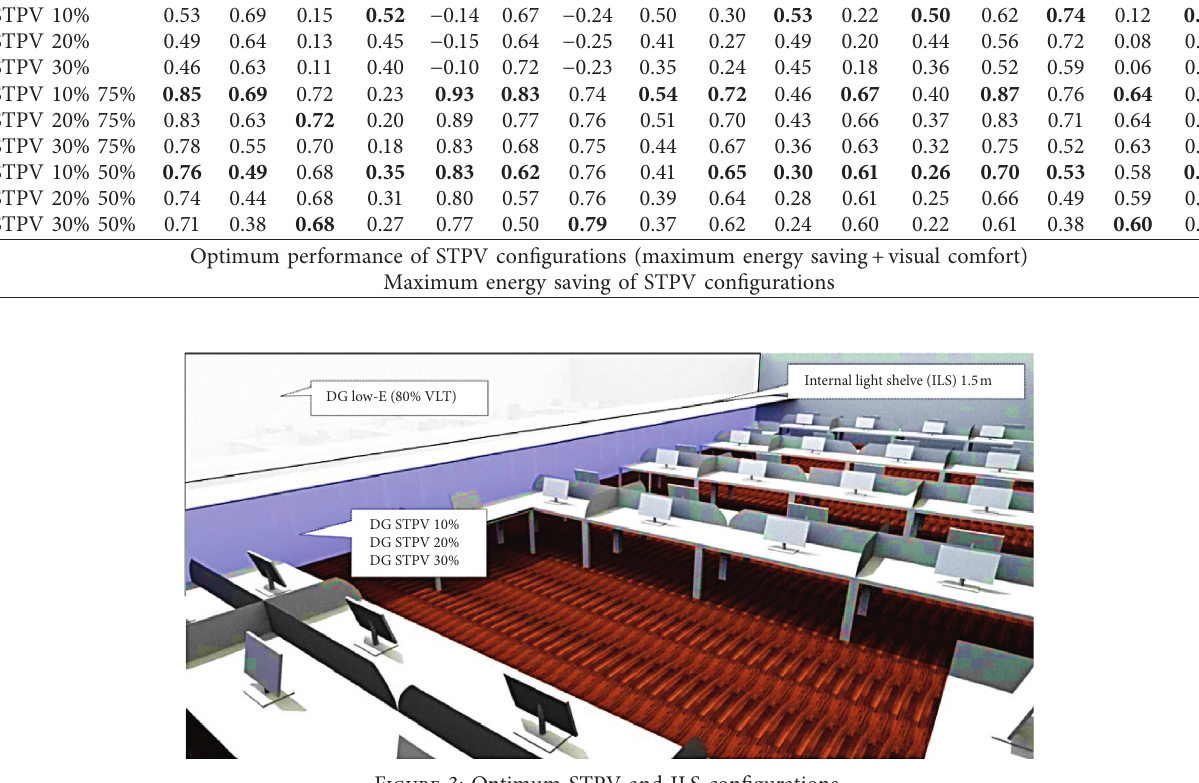
Table 18: The maximum and optimum energy saving percentages of STPV combined with ILS configurations in different climates regions. Configurations